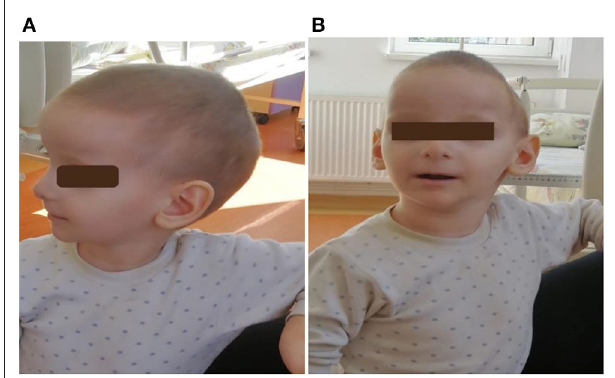
FIGURE 3 | (A,B) : First patient (child 4) at 2 years and 10 months. He had craniofacial dysmorphism, ears with thin helices, deep conchae, and hypoplastic